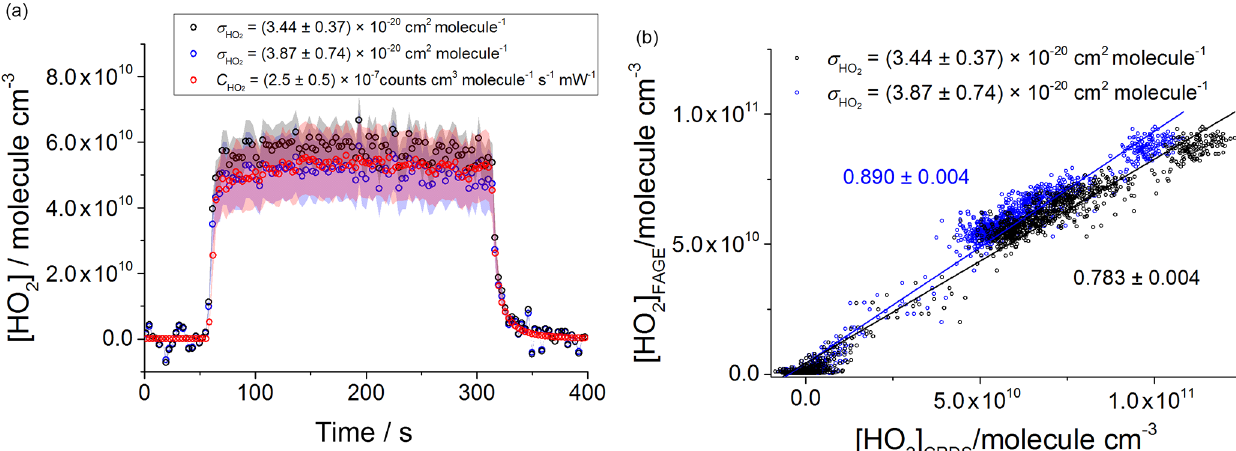
Figure 9. (a) Comparison measurement at 1000mbar where the lamps were left on for ∼ 4min. HO 2 measured by FAGE using the cali- bration factor obtained as shown in Sect. 2.3.1: the average of the value determined by the H 2 O photolysis and the value obtained using the HO 2 decays, C 1000mbar = 2.5 × 10 − 7 countscm 3 molecule − 1 s − 1 mW − 1 , red circles, is plotted with HO 2 measured by CRDS using = 3.44 × 10 − 19 cm 2 molecule − 1 , determined (Sect. 3.2) by application of pressure broadening to the spectral lines found by Thiebaud σ HO 2 = 3.87 × 10 − 20 cm 2 molecule − 1 , determined using the kinetic decays of HO et al. (2017) (black circles), and σ HO 2 in Sect. 3.3.2 (blue 2 circles). Each data point is an averaged value over 3s. [CH 3 OH] ∼ 1.65 × 10 15 moleculecm − 3 , and [Cl 2 ] ∼ 1.10 × 10 14 moleculecm − 3 . = 3.44 × 10 − 20 cm 2 determined as shown in (b) Correlation plot at 1000mbar for data in (a) . [HO 2 ] CRDS was calculated using σ HO 2 = 3.87 × 10 − 20 cm 2 determined as shown in Sect. 3.3.2 (blue). Gradients of linear unweighted fits to the data Sect. 3.2 (black) and σ HO 2 are 0.890 ± 0.004 and 0.783 ± 0.004 and intercepts of ( − 4.3 ± 0.3) × 10 9 and ( − 1.0 ± 0.5) × 10 8 moleculecm − 3 respectively. [HO 2 ] FAGE was calculated using the sensitivity factor ¯ C 1000 mbar = 2.5 × 10 − 7 countscm 3 molecule − 1 s − 1 mW − 1 , which is the average of the value determined by the H 2 O photolysis and the mean value determined using the HO 2 decays (Sect. 2.3.1). Each data point is an averaged value over